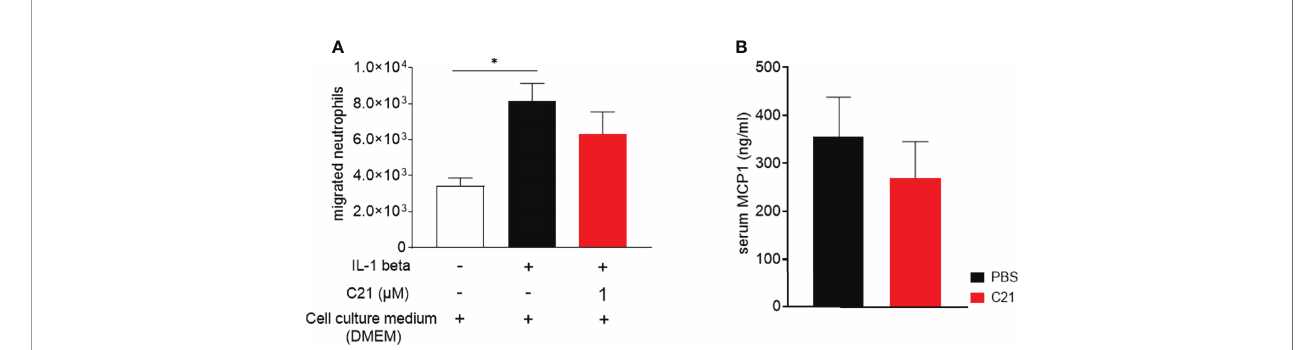
FIGURE 4 | In vitro transmigration assay of human neutrophils through C21-treated and cytokine-activated endothelial cells and MCP-1 concentrations in sera of CIA mice. (A) Mesenteric lymph node endothelial cells ( mlENDs ) were treated with 1µM C21 or medium and stimulated with recombinant mouse IL-1 beta. The numbers of migrated neutrophils were counted. Experiments were performed in triplicates and performed three times each. P*<0.05. Values shown are the mean ± SEM. P-values were calculated by one-way ANOVA followed by Bonferronis ’ s correction for multiple comparisons. (B) MCP-1 concentrations were measured by ELISA in serum samples on day 47 of the early therapeutic approach. PBS (n=30), C21 (n=26). Values shown are the mean ± SEM. P-values were using the Kruskal-Wallis test followed by Dunn ’ s post hoc test for